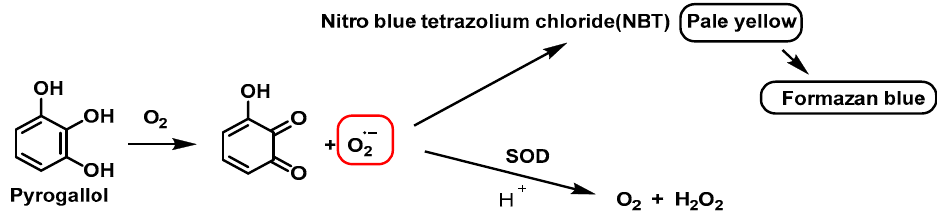
Figure 39. Generation of the superoxide radical by the chemical autoxidation of pyrogallol. The detector for this radical is a dye, NBT, a yellow compound which, in the presence of superoxide radical, is reduced, giving an intensely blue compound, formazan blue, Figure 40.